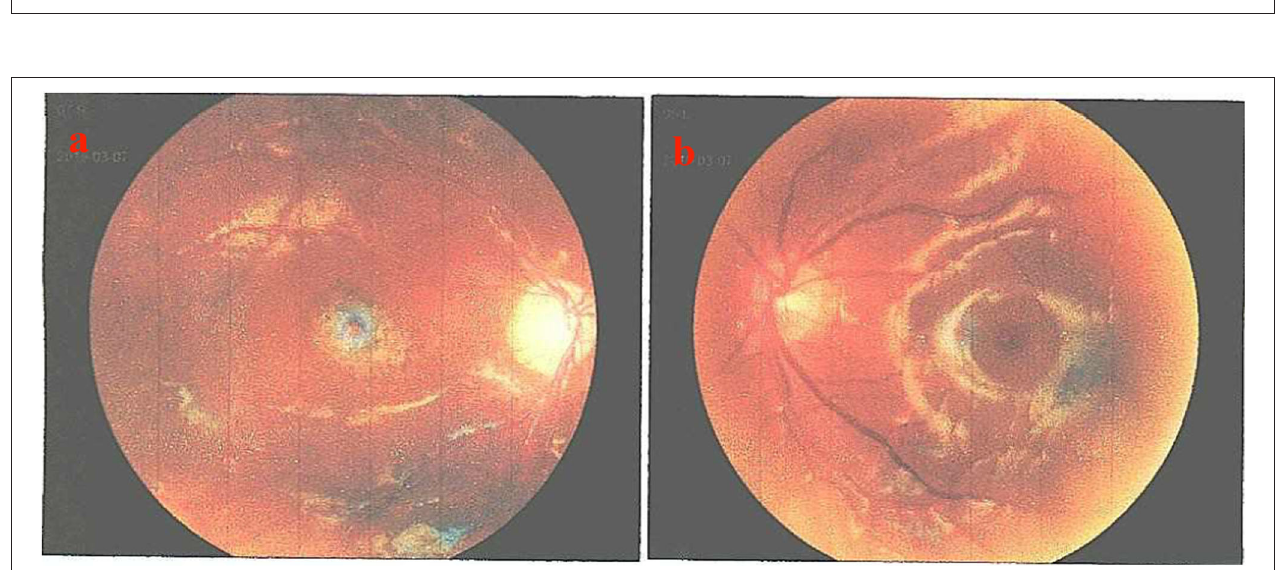
FIGURE 2 | Histopathological changes in the patient. (A) The mucosal tissue of the ileocecal junction was denatured and necrotic, with ulcerative changes. (B) Neutrophils accumulated in the lumen of the gland with chronic inflammation, and a crypt abscess was seen (arrow). (C) A few neutrophils were seen infiltrating the mucosa of the transverse colon. (D) No obvious abnormality was observed in the intestinal crypt of the ileocecal mucosa.